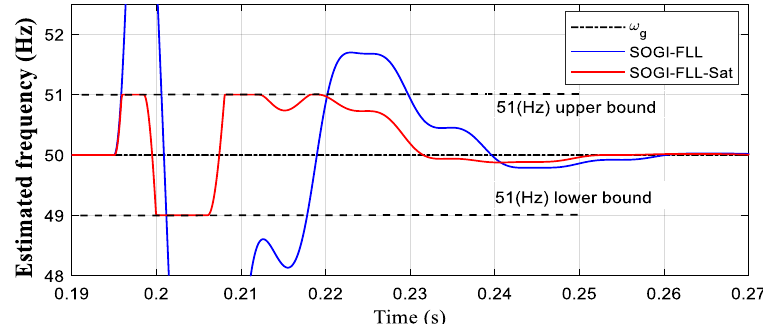
Figure 5. SOGI-FLL response to an 80% depth type-a voltage sag. In blue: without a saturation block. In red: with a saturation block.